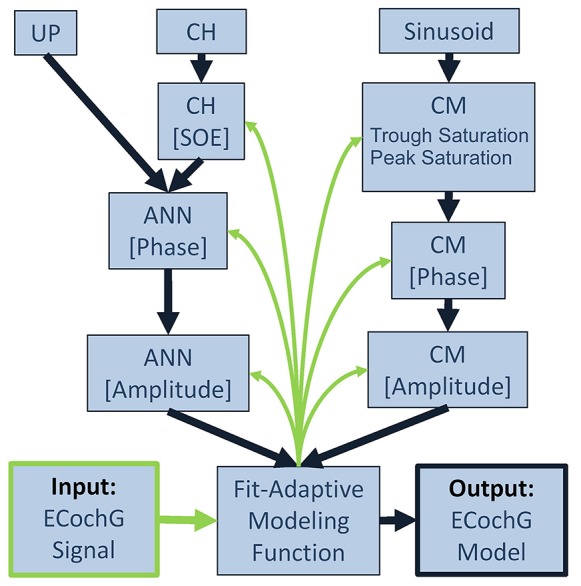
Block diagram for fitting an observed ECochG to model parameters. The ongoing portion of a recorded/input ECochG signal (lower left corner) is the basis for a fit-adaptive modeling function (center, bottom). To estimate the hair cell contribution (right column), the fitting function generates a sinusoidal CM at the stimulus frequency and optimizes the coefficients for amplitude and phase, and saturation of the peaks and troughs of the response. To estimate the neural contribution (left column), a unit potential is convolved with a cycle histogram of variable spread of excitation (SOE) and the resulting ANN amplitude and phase are also optimized. The output of the model is the estimated ongoing ECochG and its associated CM and ANN parameters (lower right corner).